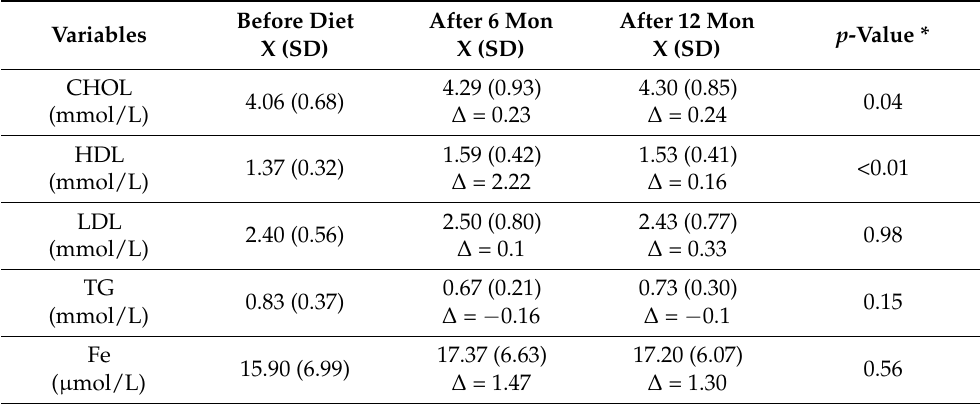
Table 2. Changes of biochemical parameters in the studied